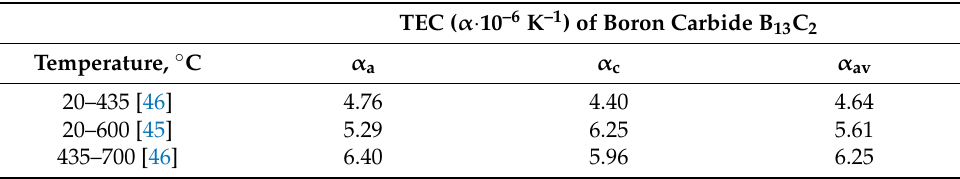
Table 3. Values of coefficients of thermal expansion, according to works [45,46].